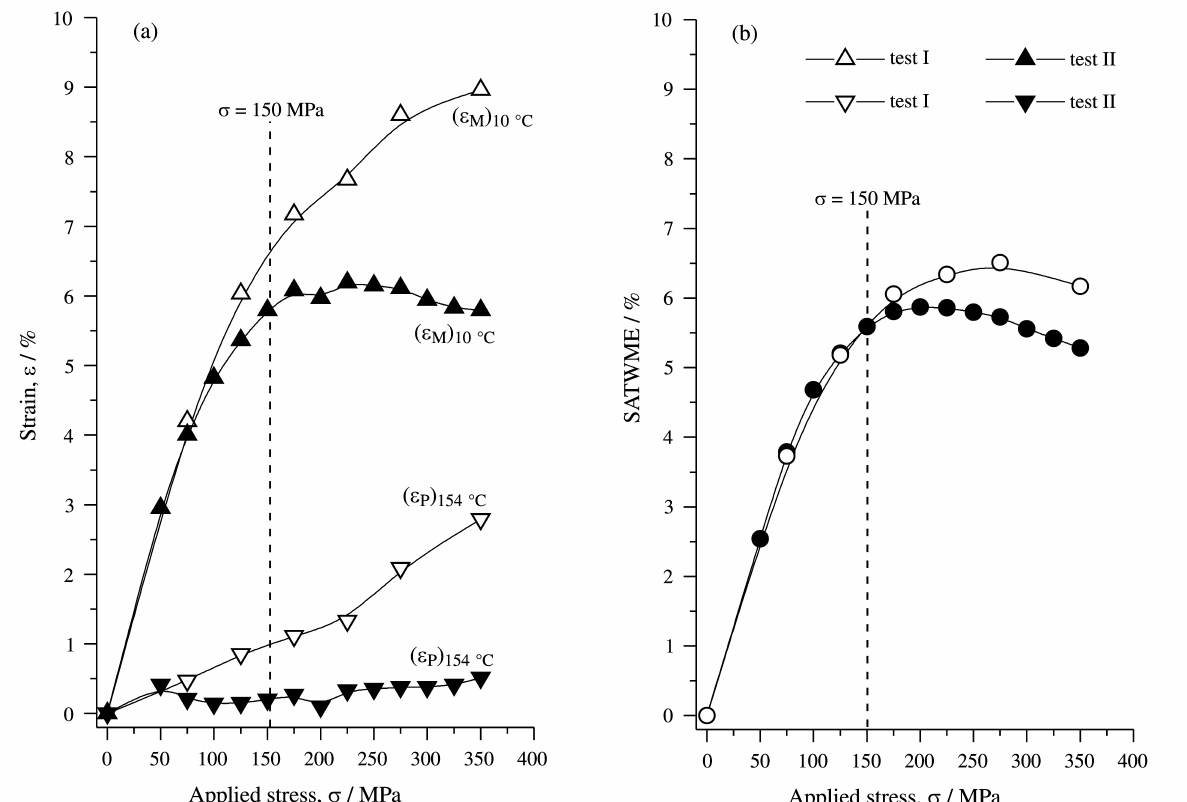
Figure 4. Strains as a function of the applied stress for tests I (open symbols) and II (solid symbols). (a) Transformation strain ( ε M ) 10°C and plastic strain ( ε P ) 154°C . (b)